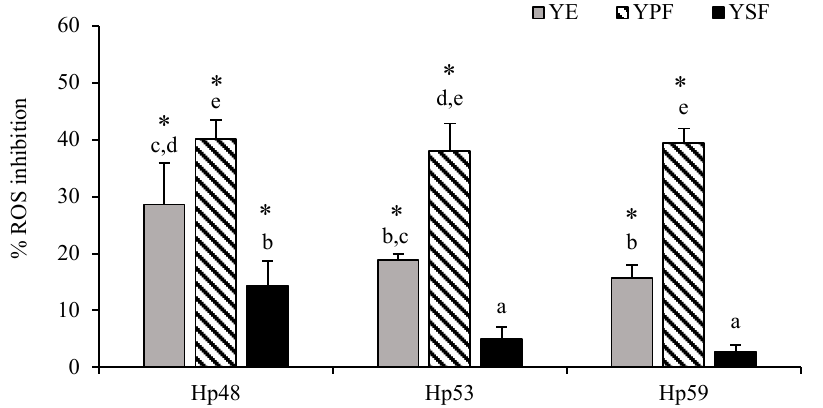
Figure 1. Inhibition effect of yarrow extract (YE) and its fractions (YPF and YSF) (0.08 mg/mL) on ROS production by human gastric epithelial AGS cells after H. pylori strains infection. Values are the mean ± SD ( n = 3). * Asterisk indicates significant differences compared to the untreated infected control (no inhibition) ( p < 0.05). a,b,c,d,e Different letters indicate statistical difference between samples and H. pylori strains ( p < 0.05).